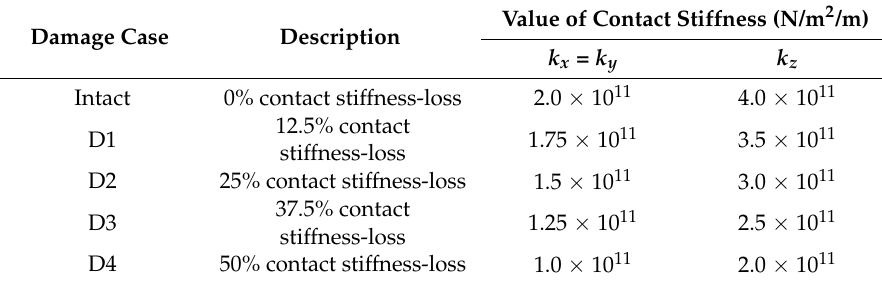
Table 3. Damage cases of the finite element (FE)